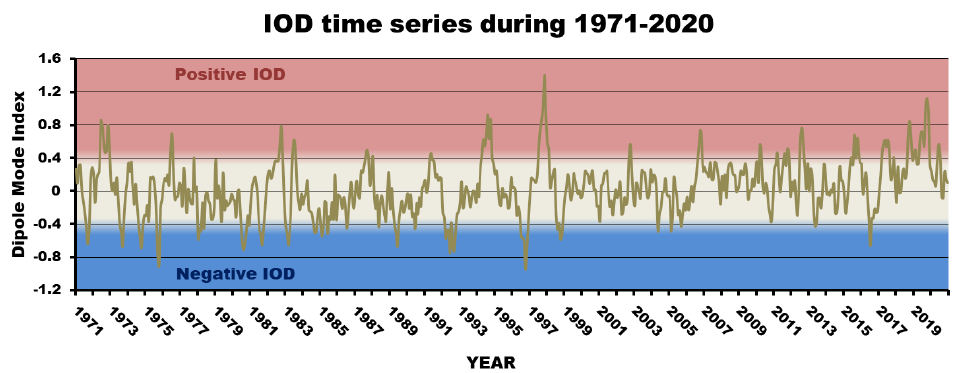
Figure 1. IOD index (degC) for all the months from 1971 to